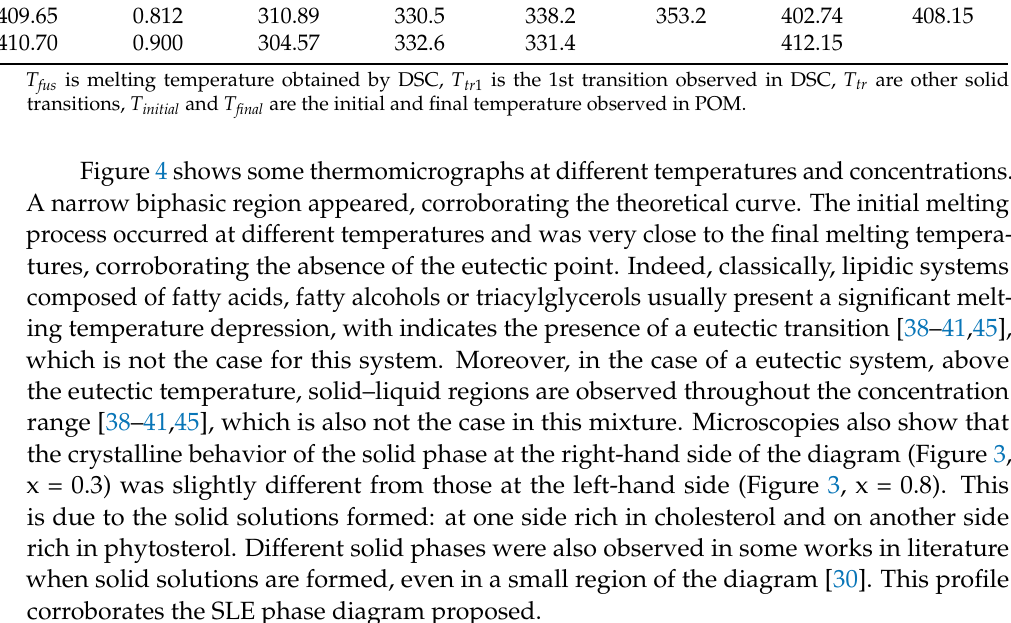
( b ) Figure 4. ( a ) Micrographs for cholesterol + phytosterol mixtures and for ( b ) cholesterol + γ -oryzanol mixtures (LC = Liquid Crystal; L = Liquid). x = cholesterol molar composition. Figure 5 shows the powder X-ray diffractograms. Pure cholesterol and phytosterol presented different diffractometric patterns. For mixtures, other patterns were observed. This indicates that mixtures present different crystalline structures when compared to pure compounds, which is a characteristic of the formation of a solid solution. If a solid solution is not formed, mixtures would present a summation of the formers’ patterns, i.e., the same peaks at the same angles. Indeed, according to Ref. [49], a solid solution is a thermodynamic situation in which a compound is fitted to the crystal lattice of other com- pounds, forming a unique crystalline cell. This crystalline cell can be similar to one or other former compound, which was observed by Maximo and co-workers in works where lipidic systems were evaluated [28,29]. In this work, for concentrations closer to pure cho- lesterol (x = 0.6 and 0.8, Figure 4) mixtures presented some peaks at the same angles ob- served for pure cholesterol, meaning that, in this range, cholesterol acted as the “host” of the crystalline unit cell of the solid phase. Otherwise, for concentrations closer to phy- tosterol (x = 0.2 and 0.4, Figure 4), diffractograms presented some peaks at the same angles that were observed for phytosterol. This means that, in this region, the cocrystal (solid solution) adopted the crystalline matrix of the phytosterol, and in this case, this pseudo- compound acted as the “host” of the structure.